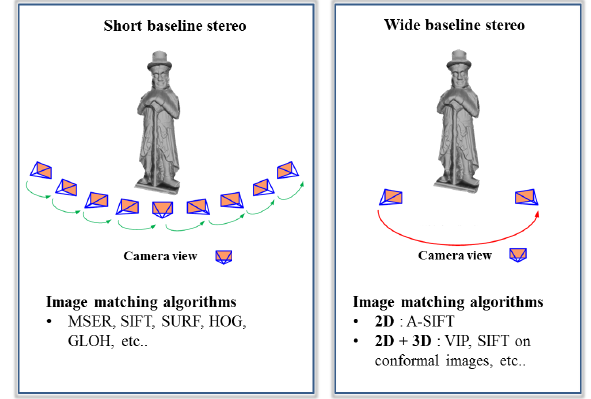
Figure 4: Short or wide baseline stereo with the matching algo- rithms.